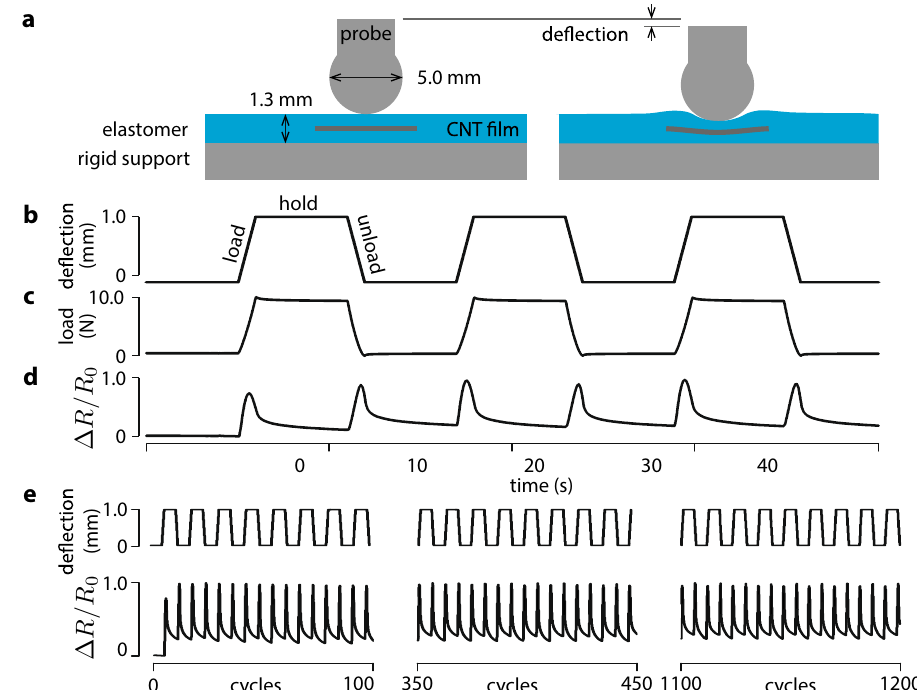
Figure 1. Sensor cell test by a spherical probe. ( a ) Sensor structure. ( b ) Testing sequence. ( c ) Resulting load. ( d ) Relative change of resistance � R = ( R − R 0 )/ R 0 . ( e ) Repeated tests and